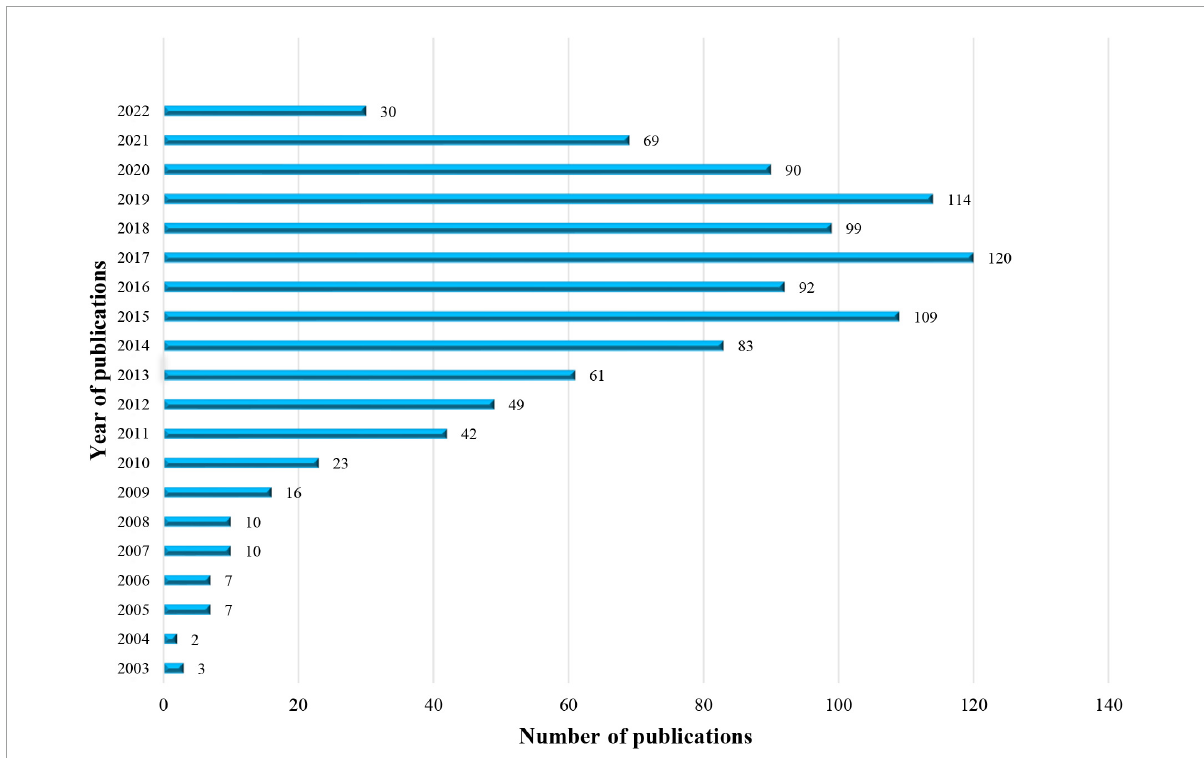
FIGURE2 The number of articles about non-coding RNA and hepatitis B virus (HBV)-related hepatocellular carcinoma per year from 2003 to 2022.